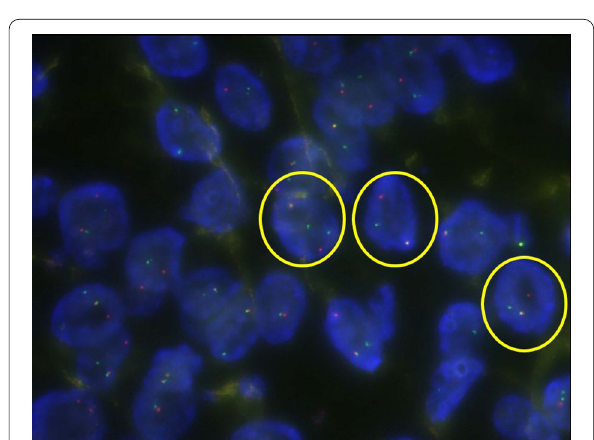
Fig. 5 EWSR1-FISH positive lesion (yellow